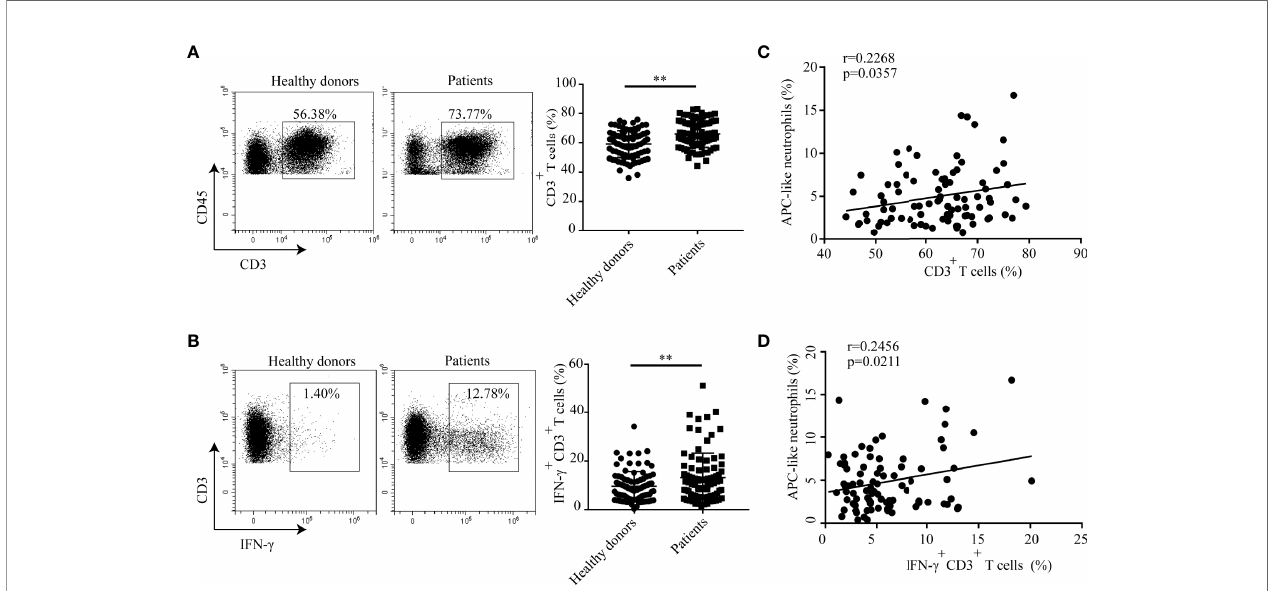
FIGURE 7 | Percentages of CD3 + T cells and IFN- g + CD3 + T cells are higher in hyperlipidemic patients than that of healthy donors. Percentage of (A) T cells and (B) IFN- g + T cell in blood of patients with hyperlipidemia and healthy donors were detected by fl ow cytometry. (C) Correlation analysis between APC-like neutrophils and CD3 + T cells in hyperlipidemic patients. (D) Correlation analysis between APC-like neutrophils and IFN- g + T cells in hyperlipidemic patients. In this set, HLA-DR + neutrophils were de fi ned as APC-like neutrophils. **p <